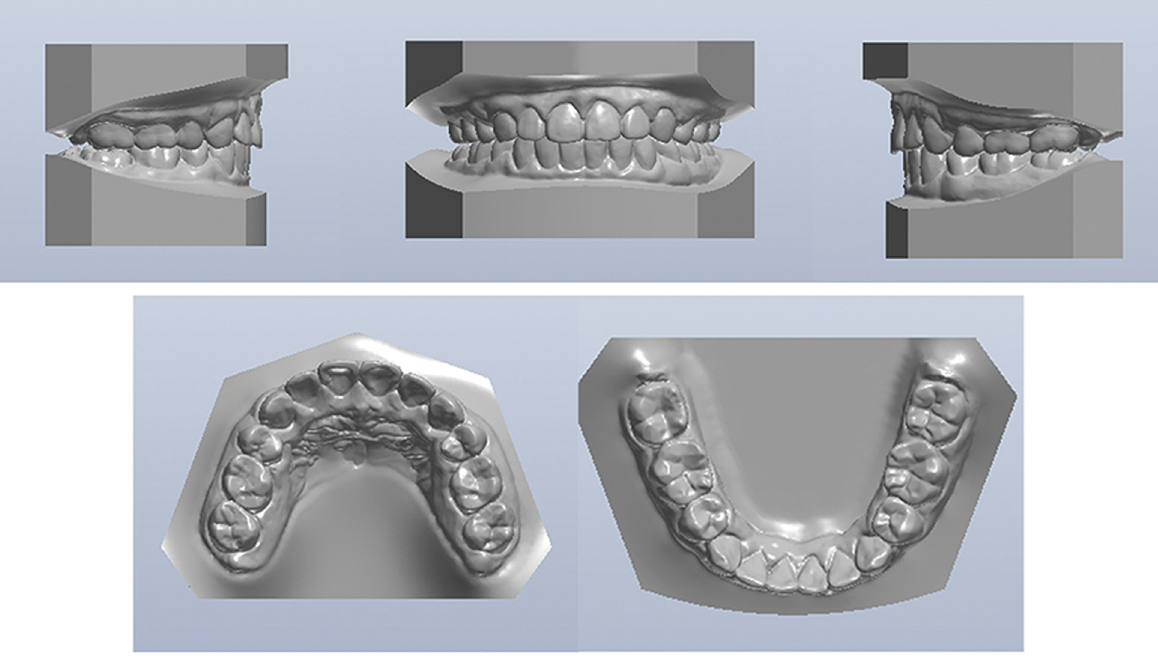
Figure 11. Posttreatment dental models.